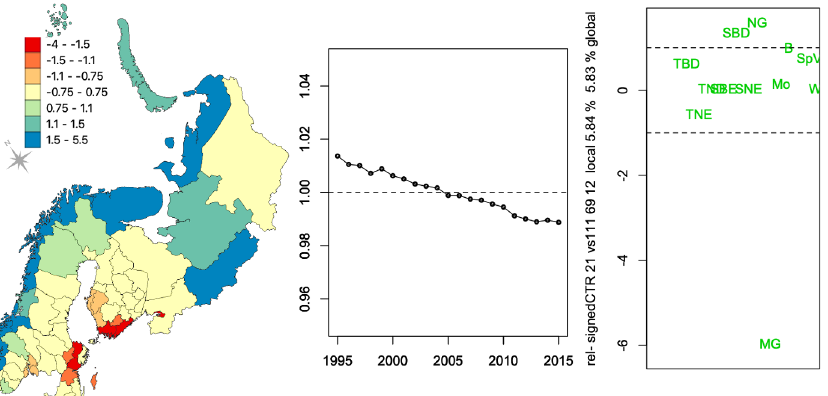
Figure 4. Second best principal tensor representing 5.83% of the variability in vegetation fractional cover per 69 districts × 21 years × 12 PFTs. The plots show the spatial, temporal, and vegetation (PFTs) component weights of the relative signed CTR (a score of ± 1, the uniform equal contribution, is indicated by the horizontal dashed line on the two figures on the right-hand side). The horizontal spread in the one-dimensional PFT plot is used simply to clarify the display; see Appendix A for the PFT acronyms (Table